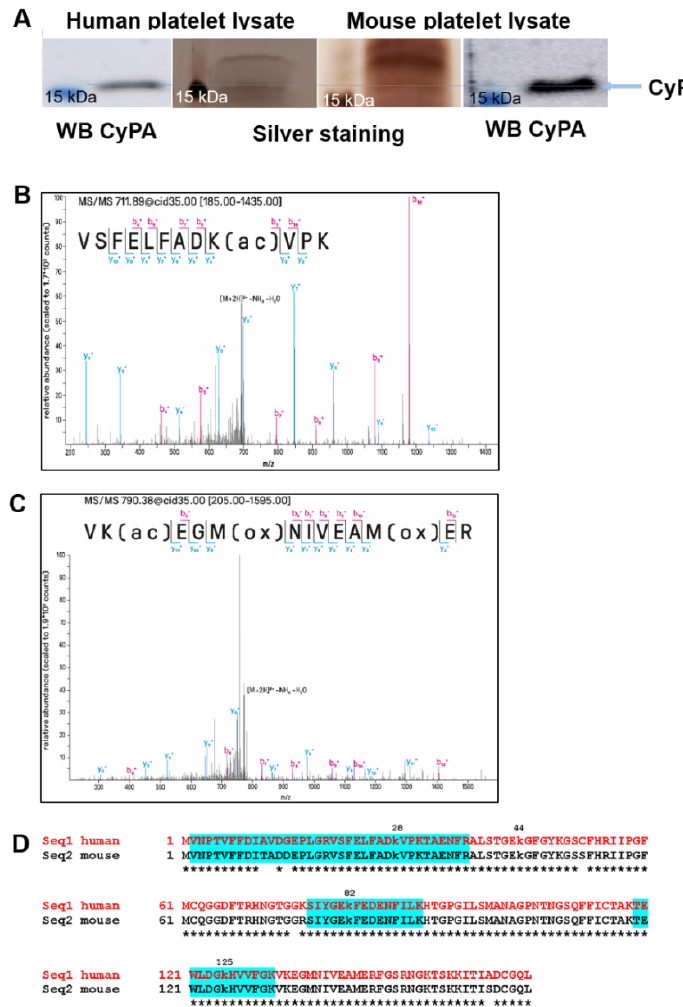
Figure 3. Detection of acetylated lysines in Cyclophilin A. ( A ) cyclophilin A Western blotting and silver staining of human and mouse platelet lysate. Human and mouse platelet lysates were separated on a 13% acrylamide gel, stained with MS-compatible silver nitrate or processed for CyPA Western blotting. After matching, silver-stained potential CyPA bands were cut out for further analyses by mass spectrometry; ( B ) MS/MS spectra of the peptide VSFELFADK(ac)VPK identified with 2 spectra matches and ion scores of 59 and 41 via Mascot database search against UniProt human by low- resolution tandem MS (LTQ Orbitrap Velos Pro) and high-resolution MS, with a mass error of +0.81 and +0.41 ppm; ( C ) MS/MS spectra of the peptide Vk(ac)EGM(ox)NIVEAM(ox)ER, which was likely to be false positive with non-matching precursor isotope-pattern, low ion scores of 35 and 22, and mass errors of − 0.07 and − 1.95 ppm (mean mass deviation of analysis +1.2 ppm). MS analysis was performed twice with different platelet preparations; ( D ) sequence alignment of human and mouse Cyclophilin A with known acetylated lysines (k). Detected peptides are highlighted in